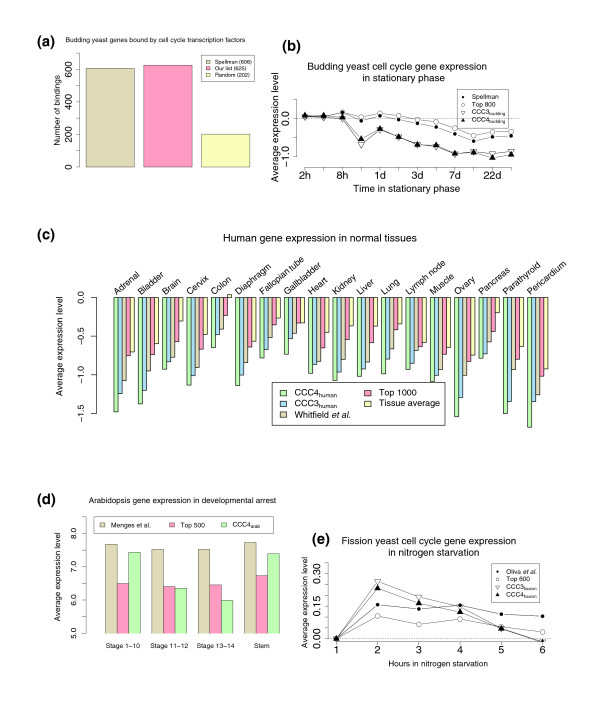
Analysis of cycling genes using complementary high throughput datasets. (a) Number of interactions between cycling genes and nine cell cycle transcription factors. (b) Average expression level of sets of budding yeast genes in stationary phase (data from Gasch and coworkers [50]). (c) Expression levels of human genes in normal tissues, using data presented by Shyamsundar and colleagues [51] (also see Additional data file 1 [Supporting Figure 4]). Genes in the conserved set have lower expression levels for most nonproliferating normal tissues when compared with the full list and the list presented by Whitfield and coworkers [1]. For 26 out of 36 normal tissues this difference is significant with a P value < 0.05. (d) Arabidopsis cells in developmental arrest experiments [52]. Flower cells in the mutants stop growing after stage 11, whereas cells in the stem grow normally. Again, the conserved set is expressed at lower levels in developmental arrest (P = 0.027 at stages 11 and 12; P = 0.003 at stages 13 and 14). (e) Expression data from studying sexual differentiation and mating in fission yeast [53].